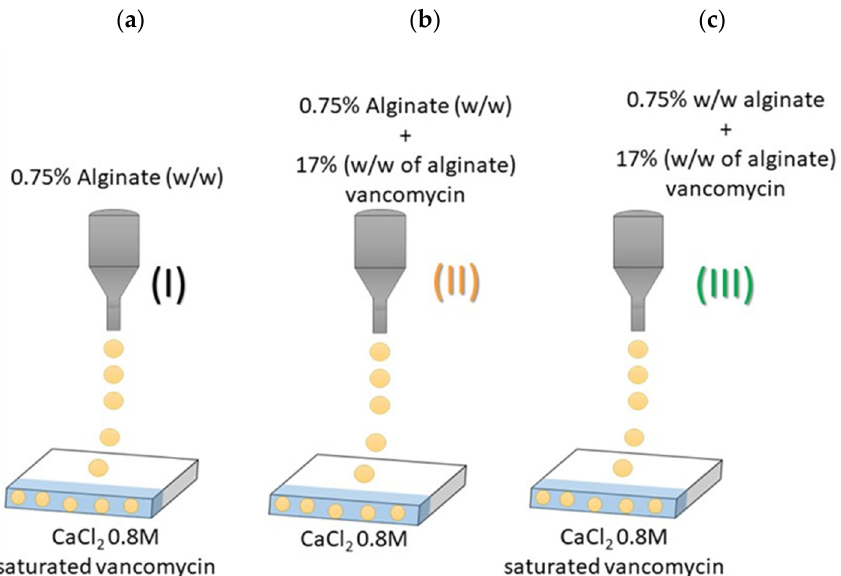
Figure 6. Different ink and gelation bath compositions for inkjet-printing of hydrogels; ( a ) Type I: 0.75% ( w/v ) alginate in the ink and a saturated bath of vancomycin in CaCl 2 O.8 M; ( b ) Type II: 0.75% ( w/v ) alginate and 17% ( w/w alginate) vancomycin forming part of the ink; and ( c ) Type III: drug both in the saturated vancomycin bath and being part of the ink.